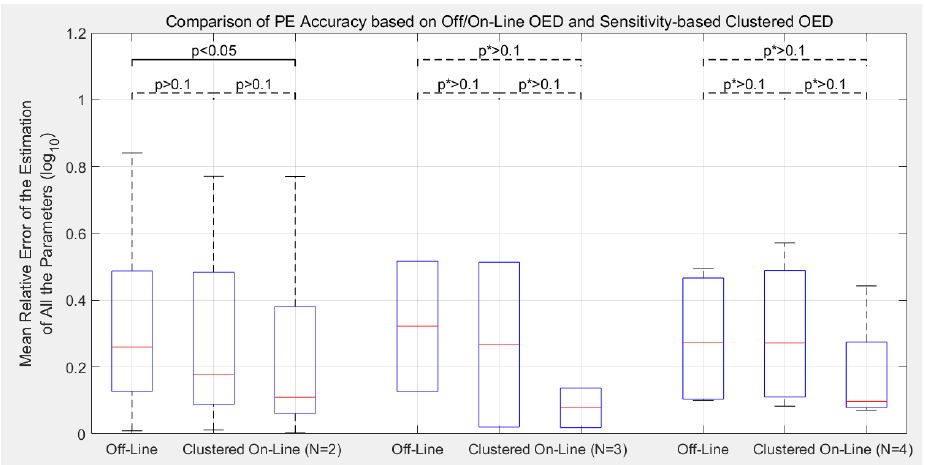
Figure 10. Comparison of the PE accuracy with off/on-line OED and sensitivity-base-clustered OED. p values stand for one-way t-test results (normal distributions), p * value is for one-sided Mann-Whitney